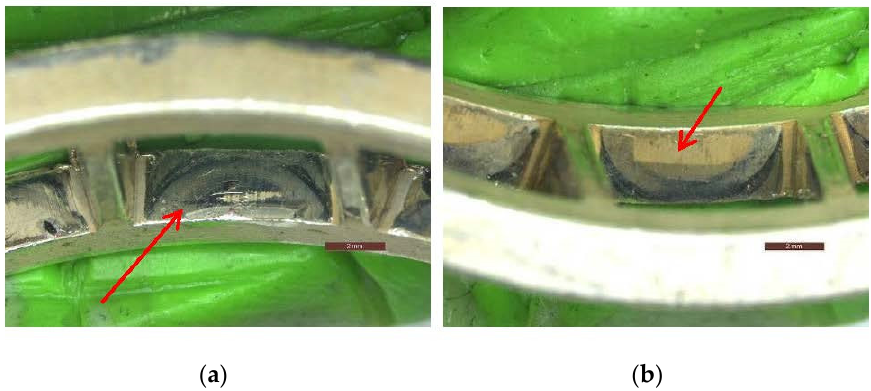
Figure 15. Contact wear morphologies of the side beams, as the arrow indicated: ( a ) wear of the side beam, corresponded to the bearing side with laser marking; ( b ) wear of the other side beam.